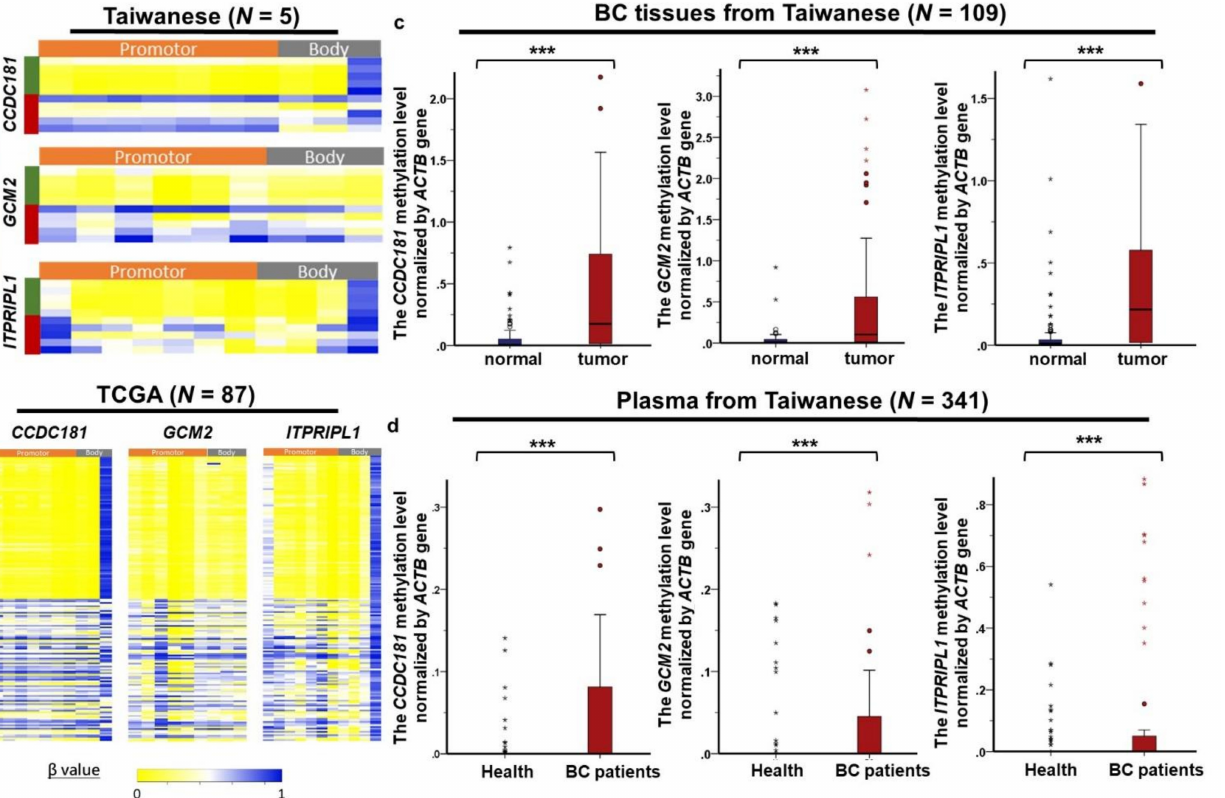
Figure 3. The methylation level of CCDC181 , GCM2 and ITPRIPL1 in tissues and plasma specimens. Differentially methylated CpG heatmap of target genes in five paired Taiwanese BC patients ( a ) and 87 paired samples from the TCGA BC dataset ( b ). Methylation levels (average β values) at differentially methylated loci were identified using Illumina methylation array-based assays. ( c ) The box plot of the target gene methylation levels in 109 BC tumors and paired adjacent normal tissues. A paired Wilcoxon test was used to calculate group differences. ( d ) The box plot of target gene methylation levels in plasma of 141 BC and 200 healthy cases. A Mann–Whitney U test was used to calculate group differences. *** all p ≤